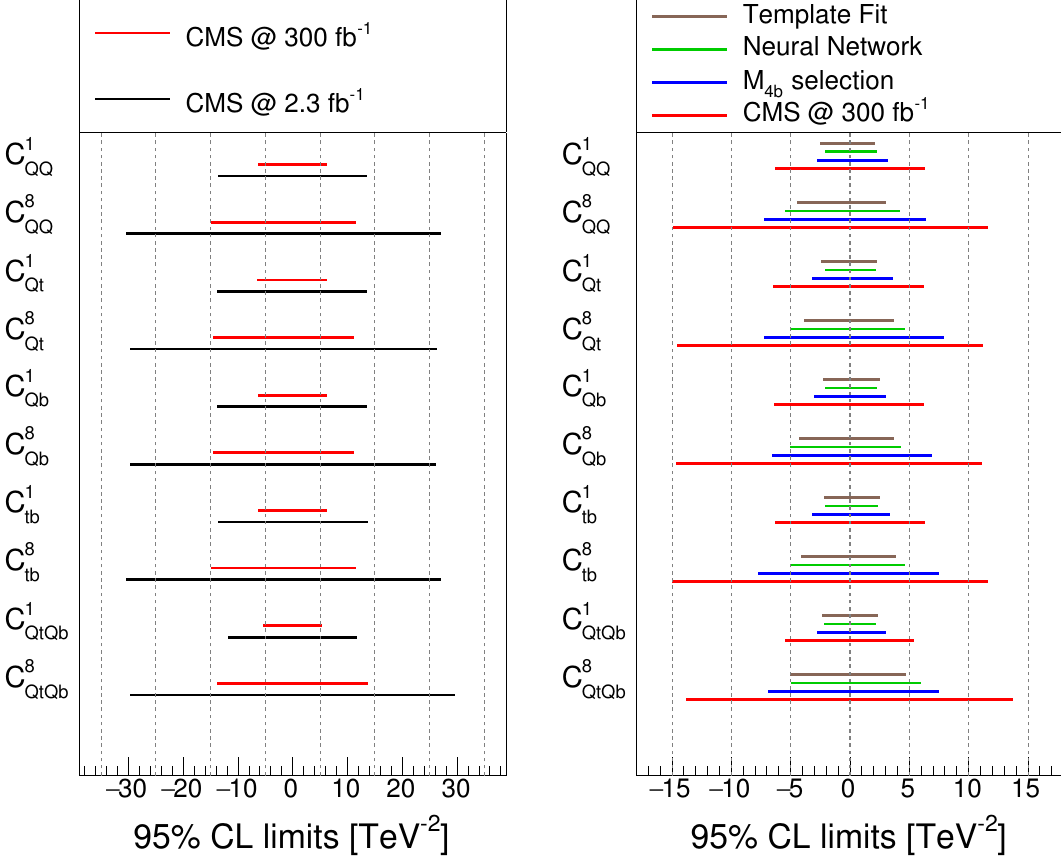
Figure 12 . (Left) Summary of the individual limits at 95% CL on all the Wilson coe(cid:14)cients, from the 13 TeV inclusive t (cid:22) tb (cid:22) b cross section measurement of CMS with 2.3 fb (cid:0) 1 (black), as well as projections for 300 fb (cid:0) 1 (red). (Right) Corresponding limits with 300 fb (cid:0) 1 obtained in this work: by making a selection on M 4 b (blue) and on the neural network output (green) and by applying template (cid:12)tting techniques to the network outputs (brown). For comparison we also include in red, the limits from the 300 fb (cid:0) 1 projection shown on the left plot. An upper cut on every energy scale of the process of M cut = 2 TeV has been applied